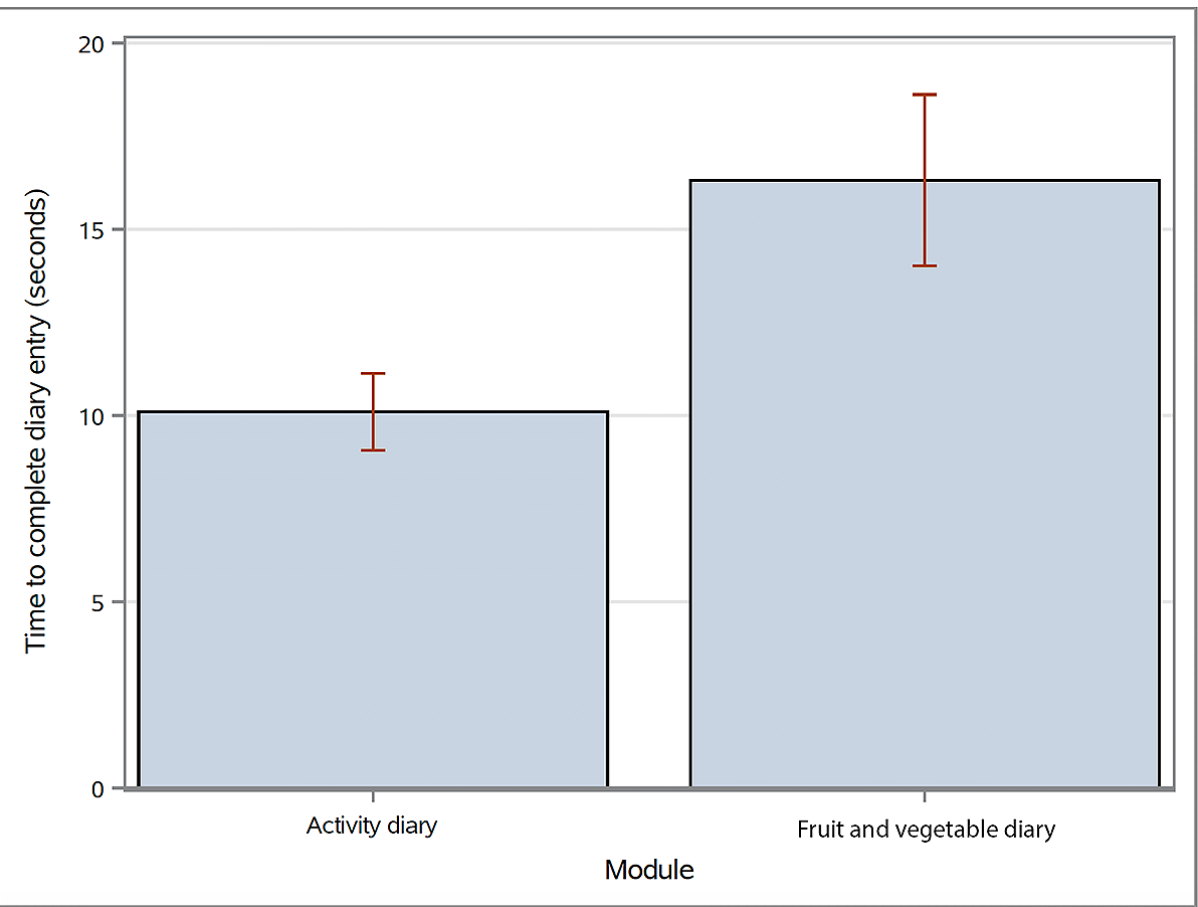
Figure 8. Average time participants took to enter a diary entry. Error bars represent Upper Confidence Level of the Mean (UCLM) and Lower Confidence Level of the Mean (LCLM). The average time was calculated by pooling all entries across all